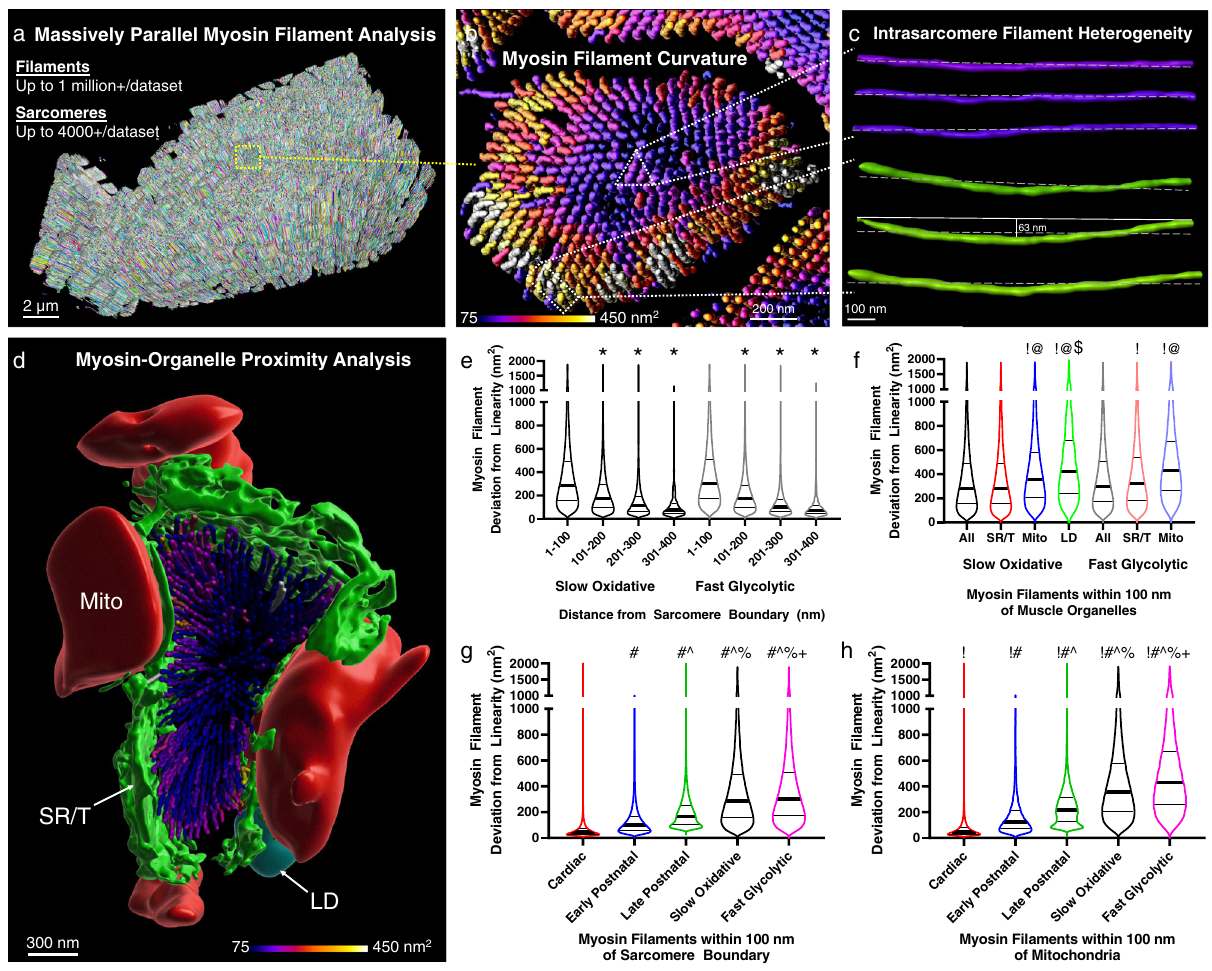
Fig. 3 | Intrasarcomere myosin fi lament heterogeneity and organelle proxi- mity. a 3Drendering of364,000+ myosin fi laments (various colors) from a mouse latepostnatalmuscle. b 3Drenderingofthemyosin fi lamentsfromthehighlighted sarcomere in ( a ). Filament color represents fi lament deviation from linearity. c 3D renderingofthreemyosin fi lamentsfromthesarcomerecorein( b )(purple,upper) and three fi laments from the periphery (green, lower) showing the variability in fi lament linearity. d 3D rendering of the myosin fi laments from a single mouse cardiac sarcomere and the organelles which comprise the sarcomere boundary. Mitochondria (Mito, red), sarcotubular network (SR/T, green), and lipid droplets (LD, cyan) are shown. e Myosin fi lament deviation from linearity as a function of distance from the sarcomere boundary for Slow Oxidative and Fast Glycolytic fi bers. f Myosin fi lament deviation from linearity for fi laments within 100nm of